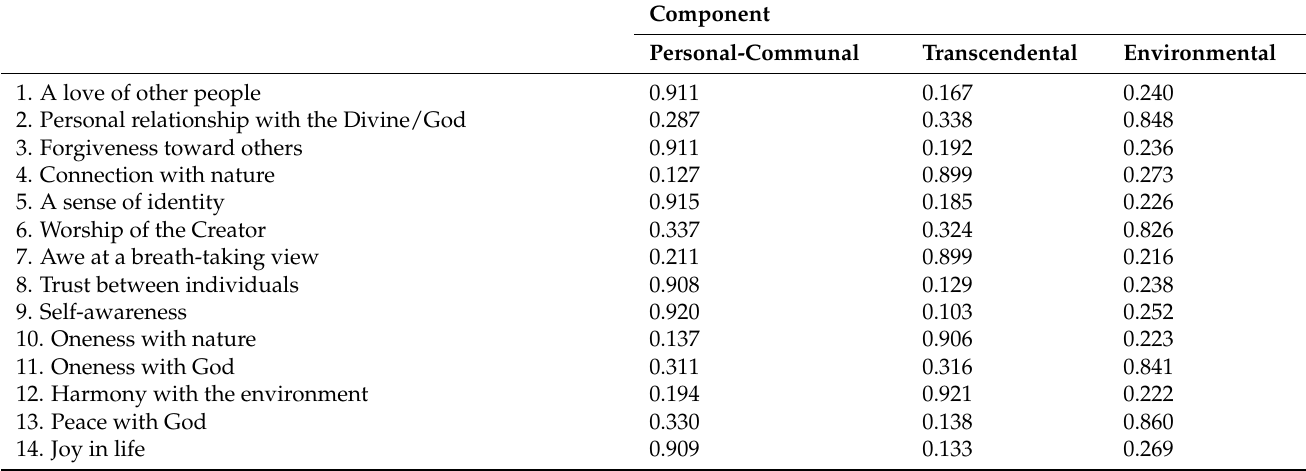
Table 1. Results of Exploratory Factor Analysis of Items on the Spiritual Well-Being Questionnaire (SWBQ) (N =